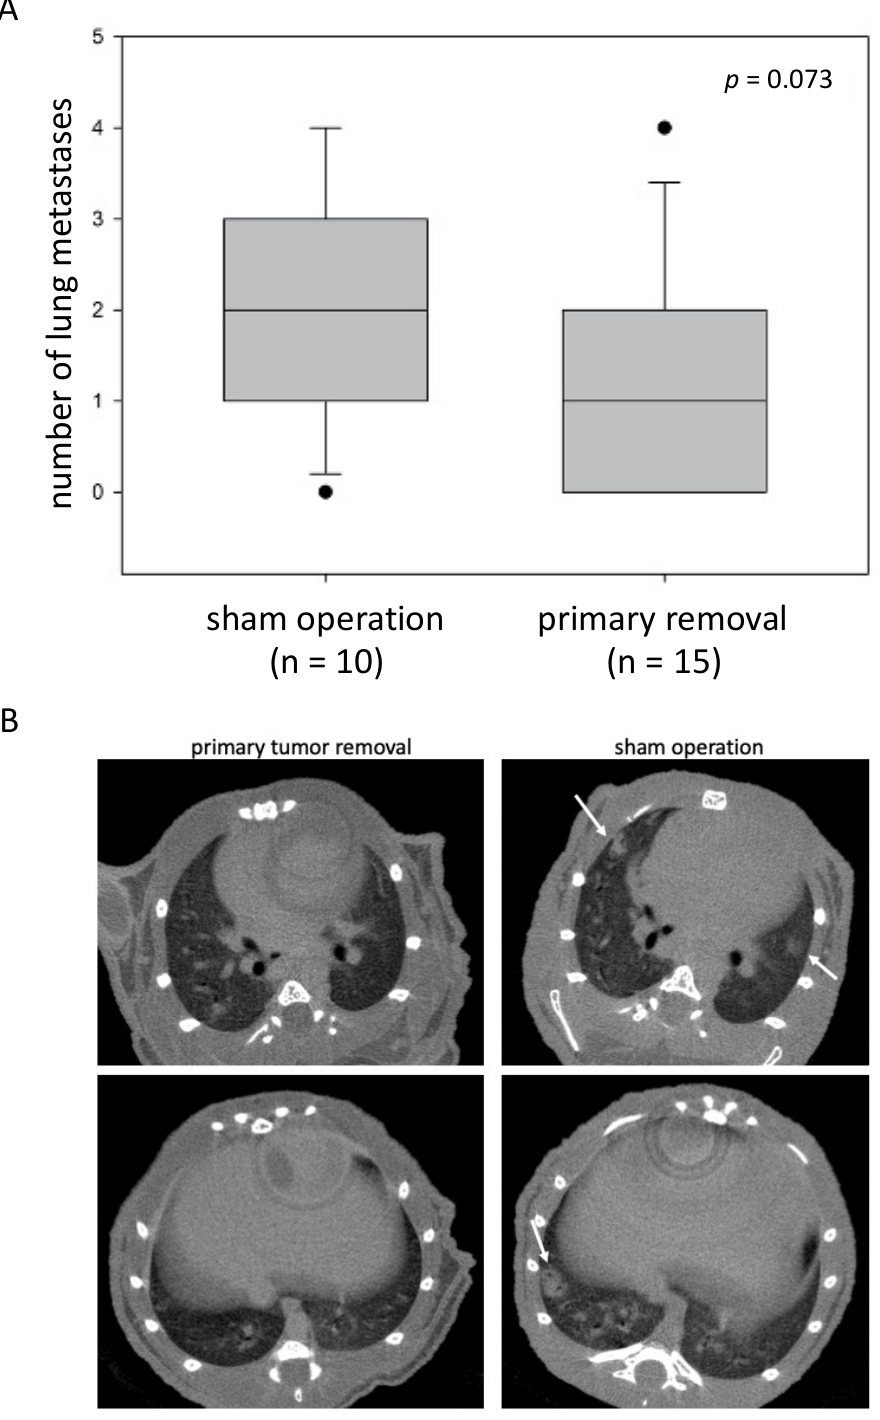
Figure 5. Extent of lung metastases after sham operation or primary tumor resection. ( A ) Number of lung metastases after sham operation or primary tumor resection, as determined by high-resolution in vivo micro-CT at week 12 after orthotopic tumor cell inoculation. ( B ) Representative cross-sectional micro-CT images of a mouse without lung metastases (after primary tumor resection, left column) and a mouse with multiple lung metastases (after sham operation, right column, metastases marked with an arrow).